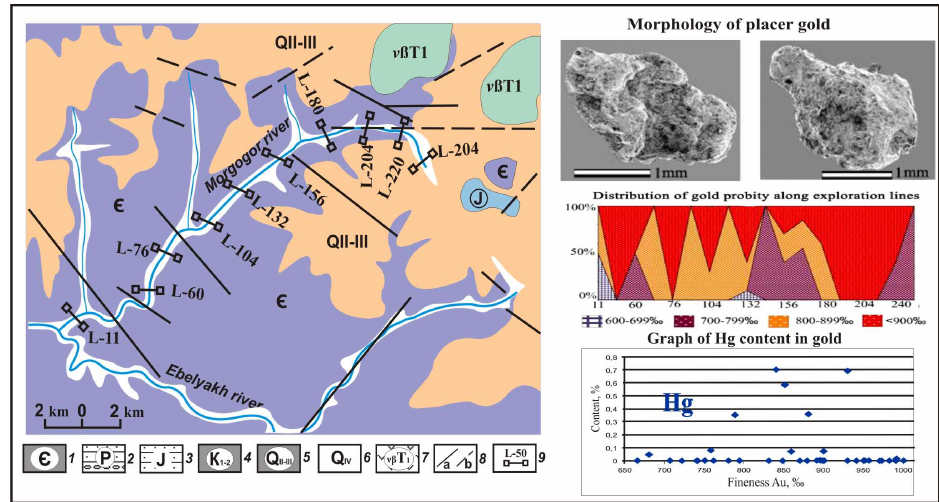
Figure 2. Mineralogical and geochemical features of placer gold of the Morgogor river. Deposits: 1—Cambrian; 2—Permian (sandstones, lenses and interlayers of claystones, siltstones, conglomerates and gritstones); 3—Jurassic (siltstones and sandstones); 4—Cretaceous (soft sandstones, lenses of gritstones); 5—Neopleistocene (pebble beds, sands, silty loams and sandy loams); 6—Holocene (alluvial formations); 7—Early Triassic intrusions of dolerites; 8—faults: а —identified, б —assumed; 9—prospecting lines.